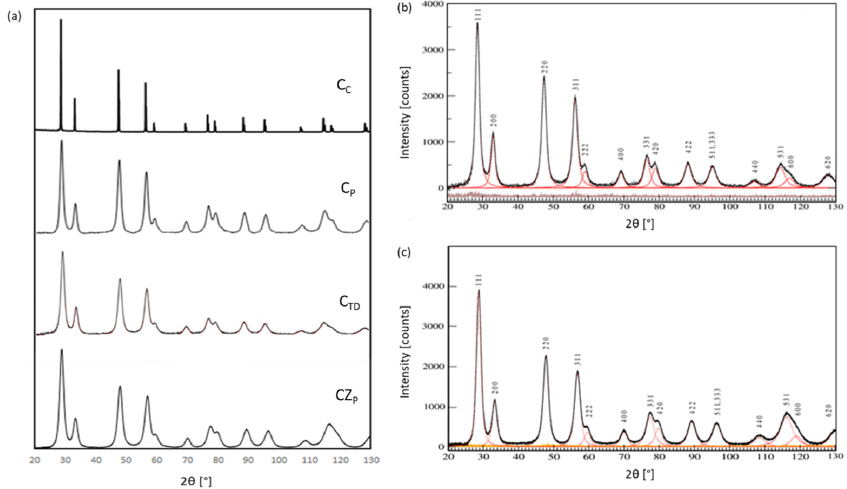
Figure 2. XRD patterns ( a ) of the three types of ceria supports and the cerium–zirconium mixed oxide and with fitted peaks for ( b ) ceria and ( c ) ceria–zirconia.